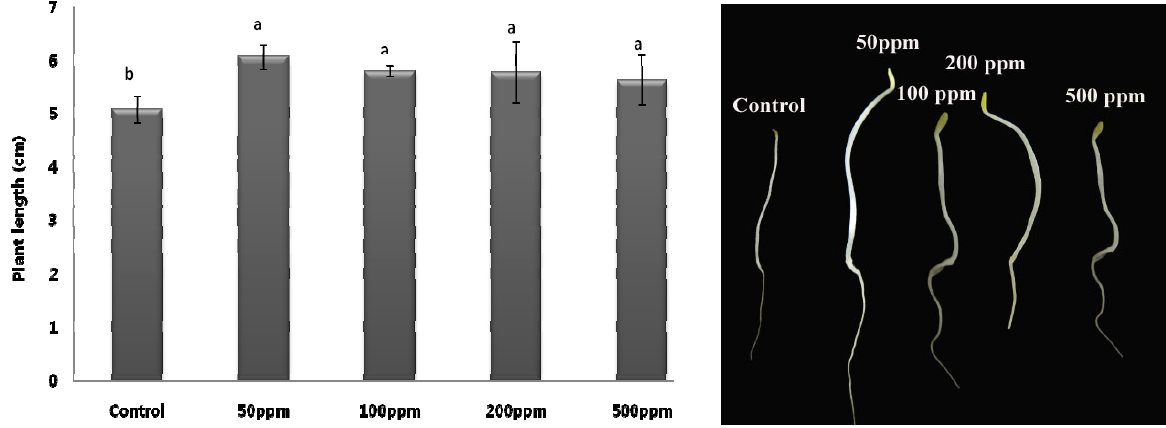
Figure 5. Effect of compound ( 1 ) on the germination and growth of lettuce seeds using various concentrations ( n = 5). For each set of treatment, the different letter indicates significant differences ( P < 0.05) between SE4 and control treatments as evaluated by Duncan multiple range test. Error bars refers to